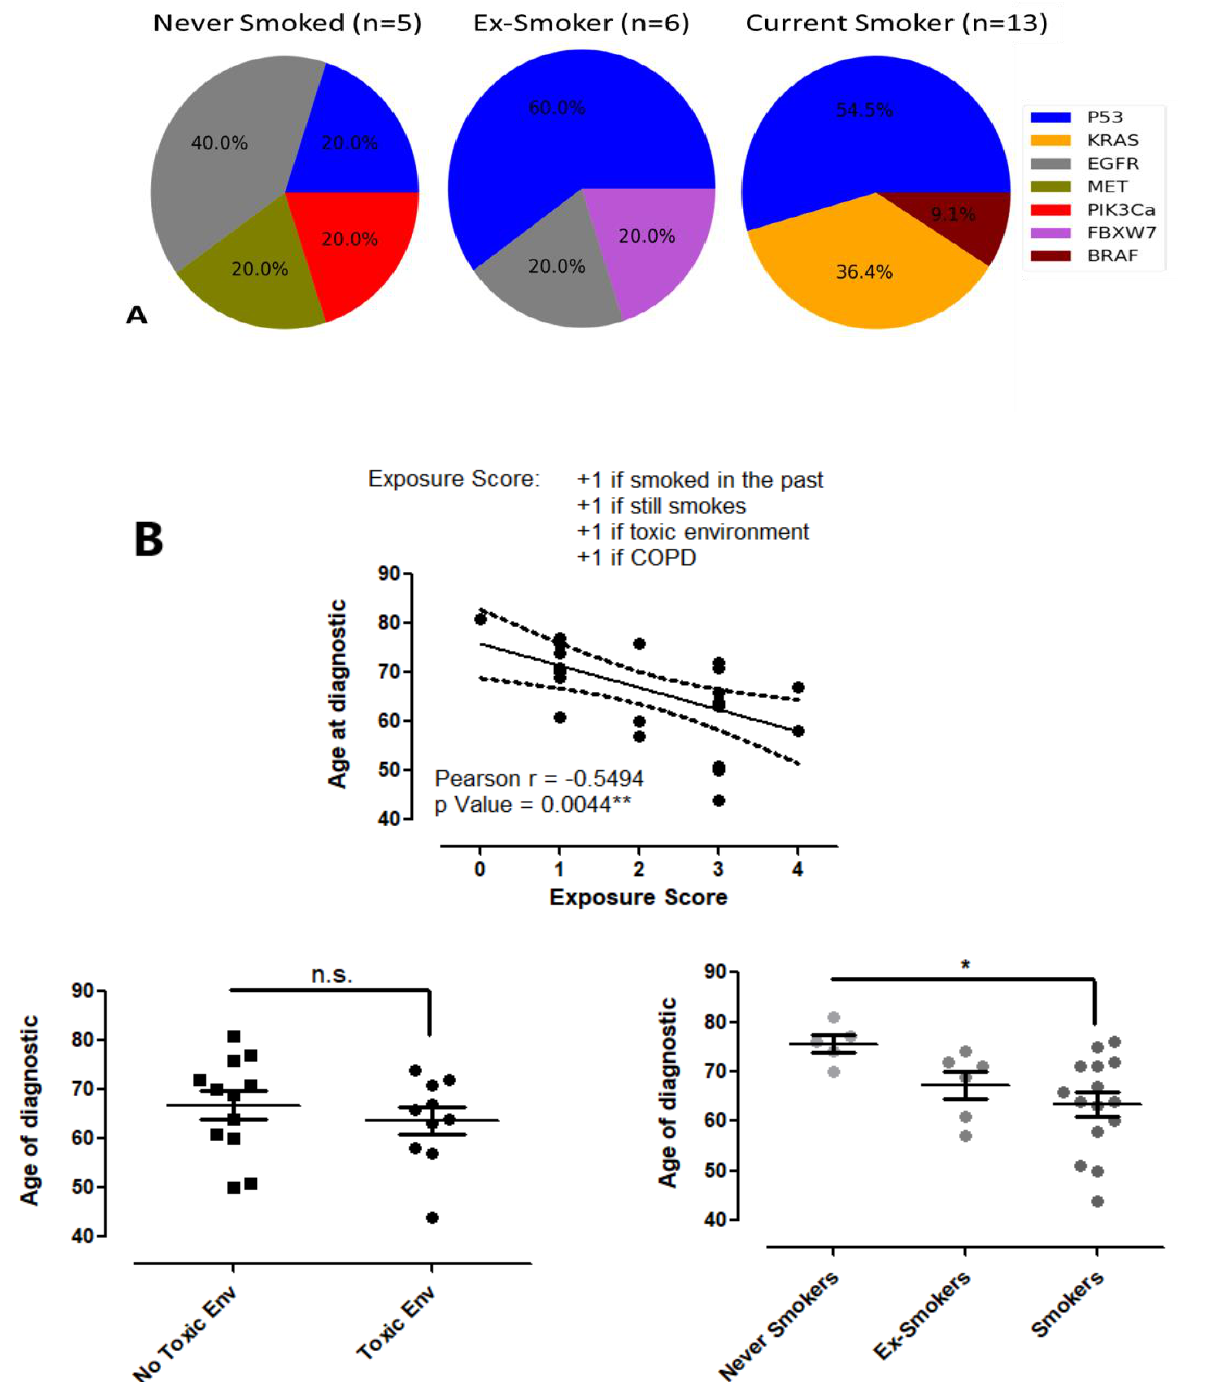
Figure 4. Lung cancer and risk factors. (Panel A ). Pie charts of tissue mutations for lung cancer patients grouped by their smoking status. (Panel B ). The age at lung cancer onset for patients with or without professional exposure to toxic substances (n.s., Student’s t -test), for non-smokers, ex-smokers, and current smokers (* p < 0.05, Current Smokers vs. Never Smoked, one-way ANOVA, Dunnett multiple comparison test), as well as the significant negative correlation between a compound exposure score and age at lung cancer onset (** p < 0.01, Pearson